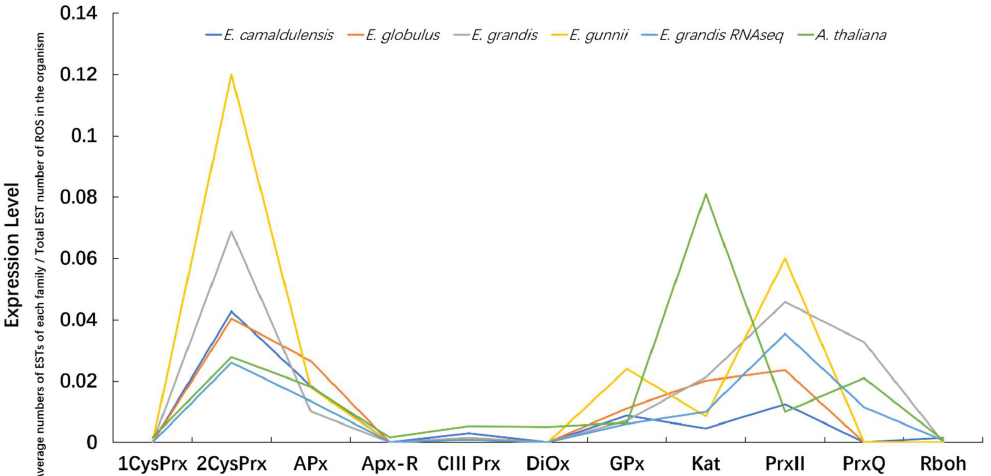
Figure 6. Expression levels of ROS gene families in the four Eucalyptus species and A. thaliana